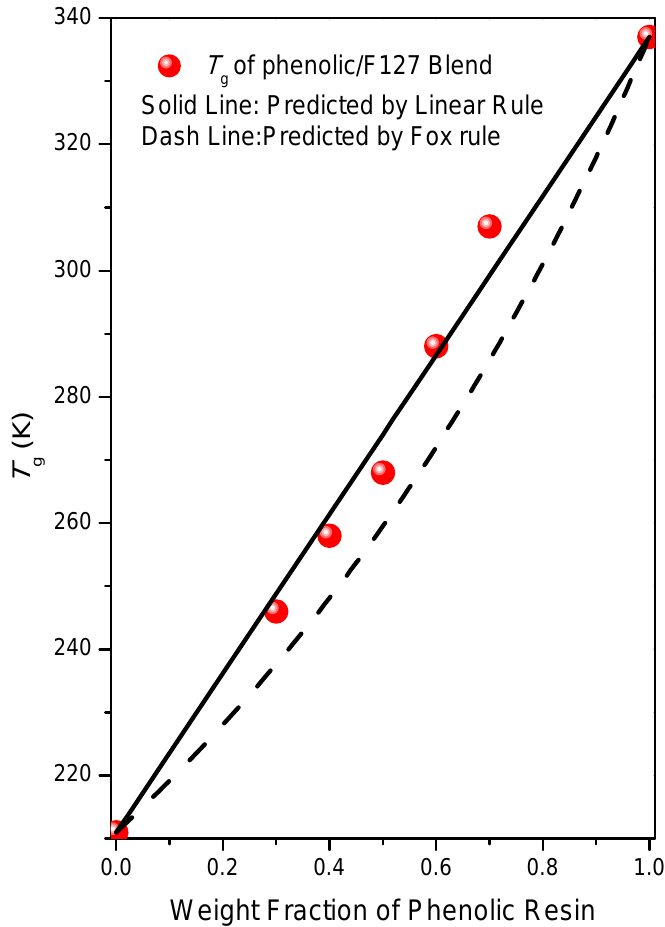
Figure 2. Glass transition ( T ) behavior of phenolic/F127 blends at various g